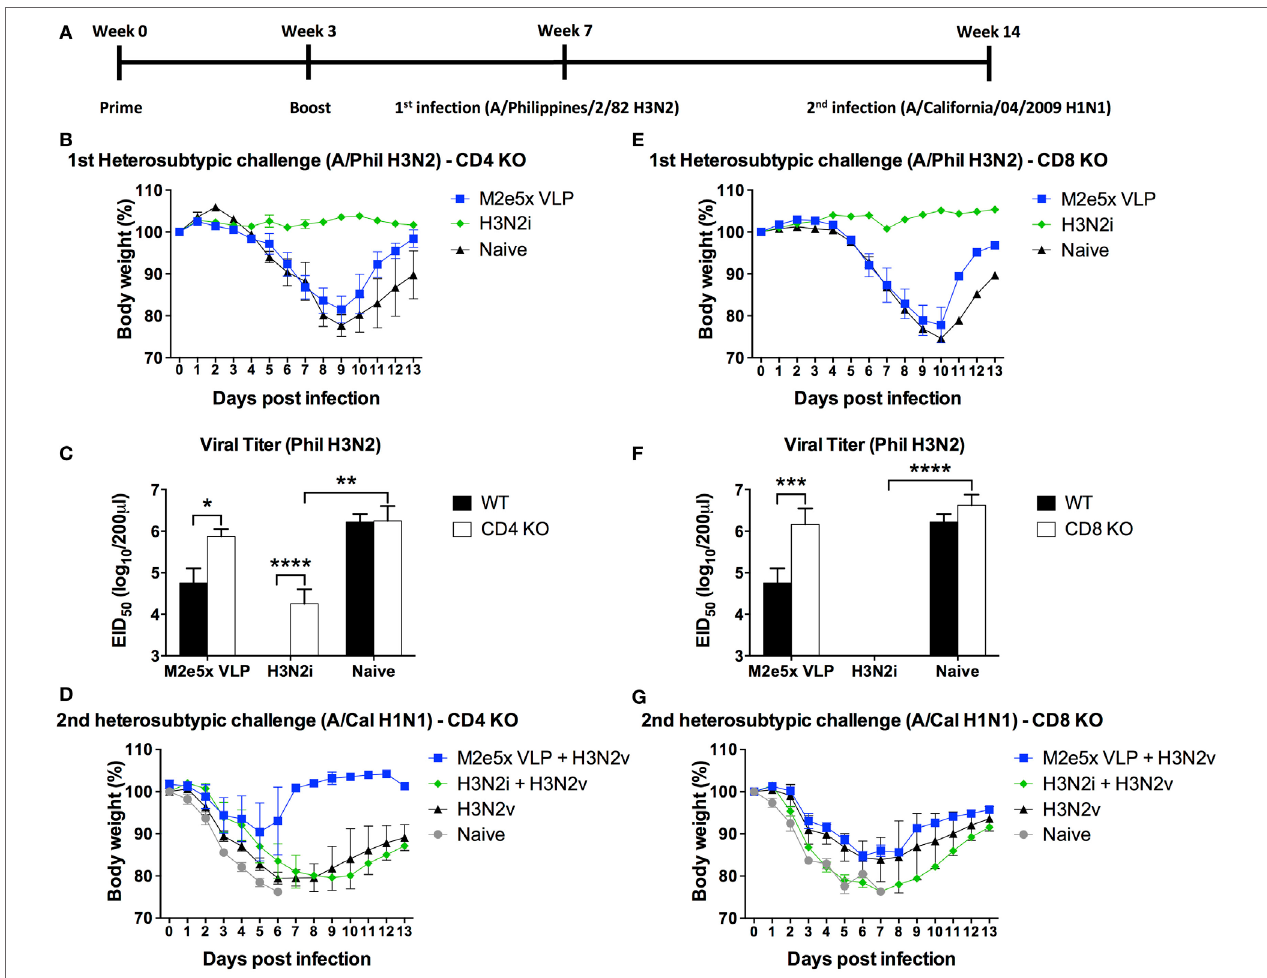
FigUre 6 | Efficacy of protection in CD4 knockout (CD4 KO) and CD8 knockout (CD8 KO) mice by different influenza vaccines after primary H3N2 virus and secondary H1N1 virus challenge. (a) Time schedule for experiments of vaccination, first challenge infection with H3N2 virus, and second challenge infection with H1N1 virus. CD4 KO (B–D) and CD8 KO (e–g) mice were challenged with A/Philippines/2/82 (H3N2) (H3N2v) at 4 weeks after boost with M2e5x virus-like particle (VLP) or H3N2i. Body weights were monitored for 14 days. Lung viral titers were determined by the egg inoculation assay (c,F) . The detection limit of 50% of egg infectious dose (EID 50 ) was 1.7 Log10. At 7 weeks after first infection with A/Philippines/2/82/(H3N2), CD4 KO (D) and CD8 KO (g) mice were challenged with a different subtype of influenza virus (A/California/04/2009 H1N1) and body weight changes were monitored for 14 days. H3N2 virus infection only group was the naïve infection group of (B,e) . Data represent the mean ± SEM. Statistical significances were evaluated by two-way ANOVA. * p < 0.05, ** p < 0.01, *** p < 0.001, **** p <